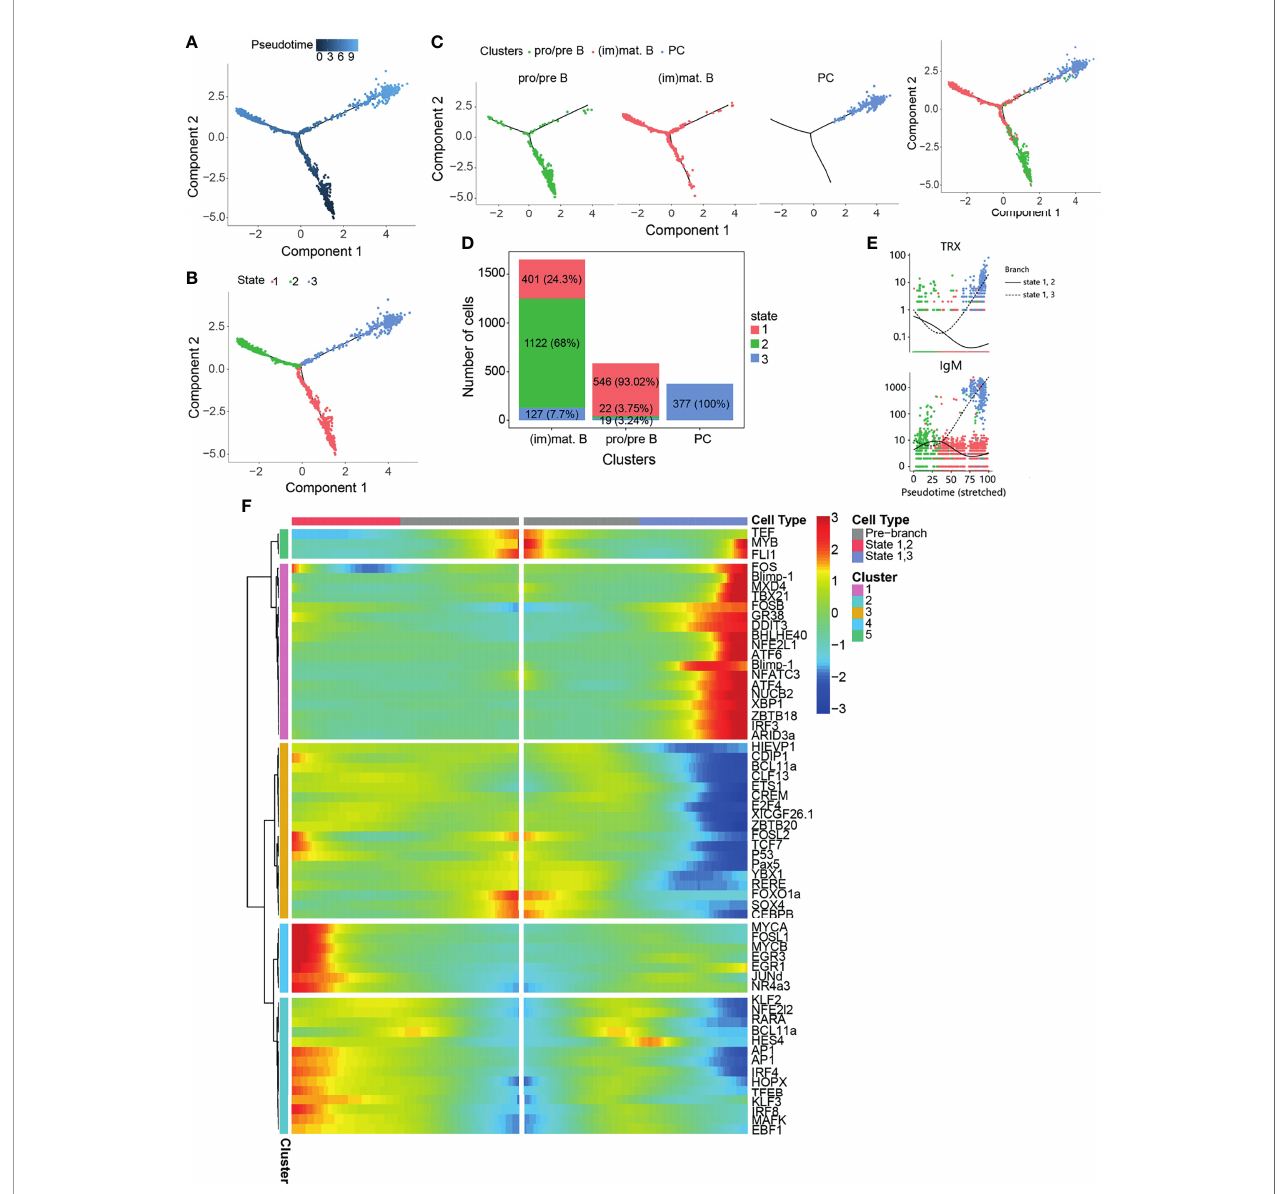
FIGURE 3 | Pseudo-temporal analysis of B-cell development using Monocle. (A) Trajectories of pre/pro B, immature/mature B cells [(im)mat. B], and plasma cells (PCs) applying pseudo-time analysis. (B) Distribution of the three trajectory states. (C) Distribution of the three B-cell subsets in the trajectory. (D) Cell numbers and percentages of each B-cell subset in the trajectory branches. (E) Monocle analysis revealing the progressive expressions of thioredoxin (TRX) and IgM across pseudo-time in two branches. (F) Heatmap of the branch-dependent transcription factors (TFs) in the B-cell trajectory